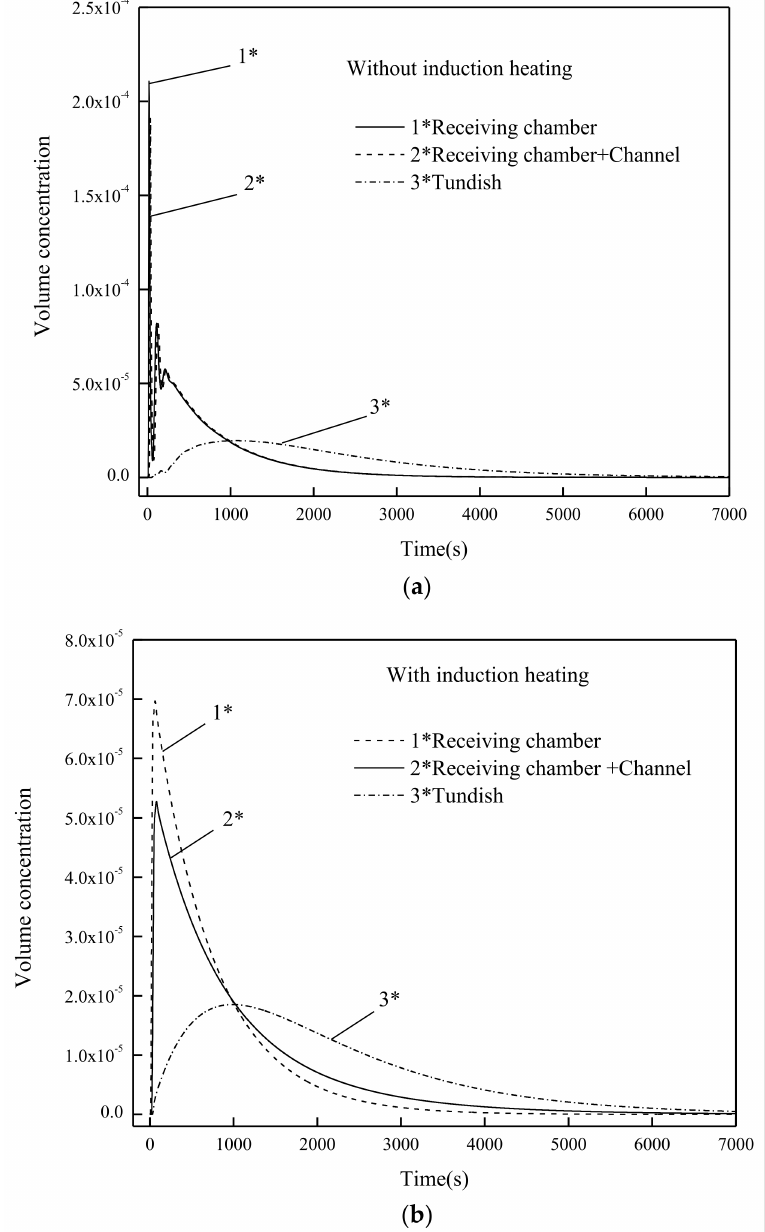
Figure 7. RTD curves in the tundish. ( a ) Without channel induction heating; ( b ) With channel induction